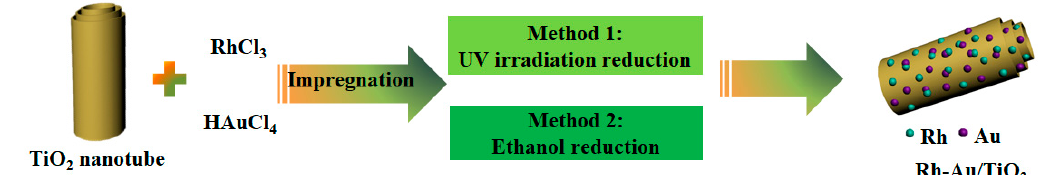
Figure S1: TEM of catalysts: TNTs (A), Au 0.49 /TNTs-2 (B), Au 0.28 /Rh 0.34 /TNTs-12 (C), Au 0.78 /Rh 0.31 /TNTs-12